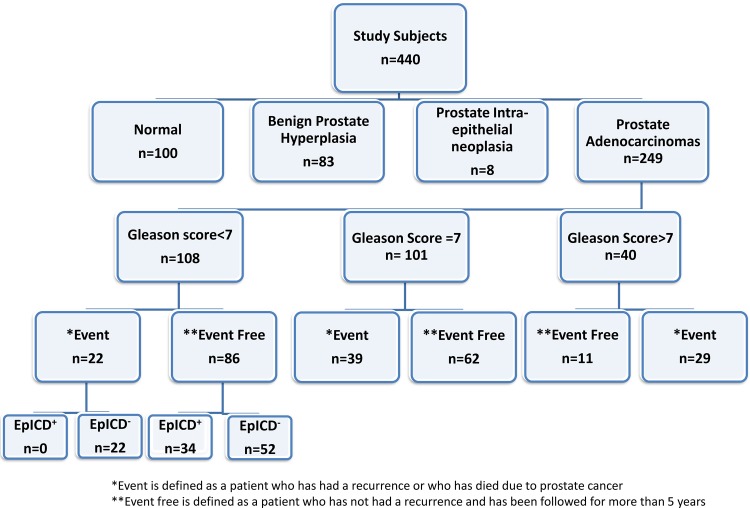
Study scheme of patient cohort.Patient cohort details are listed in a hierarchy manner.